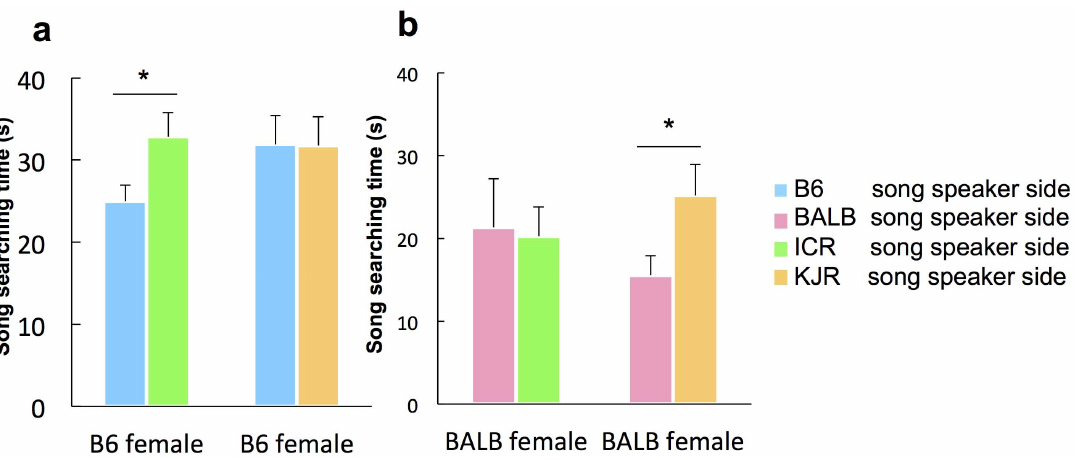
Figure 3. Female song searching response to playback with KJR and ICR strain male song. ( a ) When B6 and ICR male songs were presented, ESP1-treated B6 females showed longer search times for ICR songs than for B6 songs ( n =13), whereas there was no difference in search time when B6 and KJR male songs were presented ( n =12). ( b ) When BALB and KJR male songs were presented, ESP1-treated BALB females showed longer search times for KJR songs than for BALB songs ( n =12), whereas there was no difference when BALB and ICR male songs were presented ( n =11). Values represent means + standard error. Asterisks indicate significant differences p , 0.05.